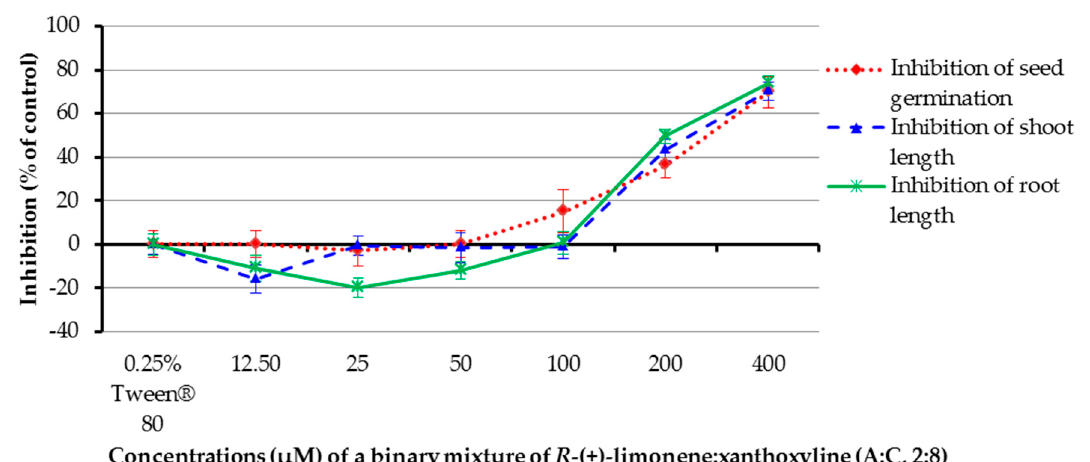
Figure 7. Inhibitory effects of a binary mixture of R -(+)-limonene:xanthoxyline (2:8) on seed germination and shoot and root growth of Chinese amaranth. A 0.25% aqueous solution of Tween ® 80 was used as a control.